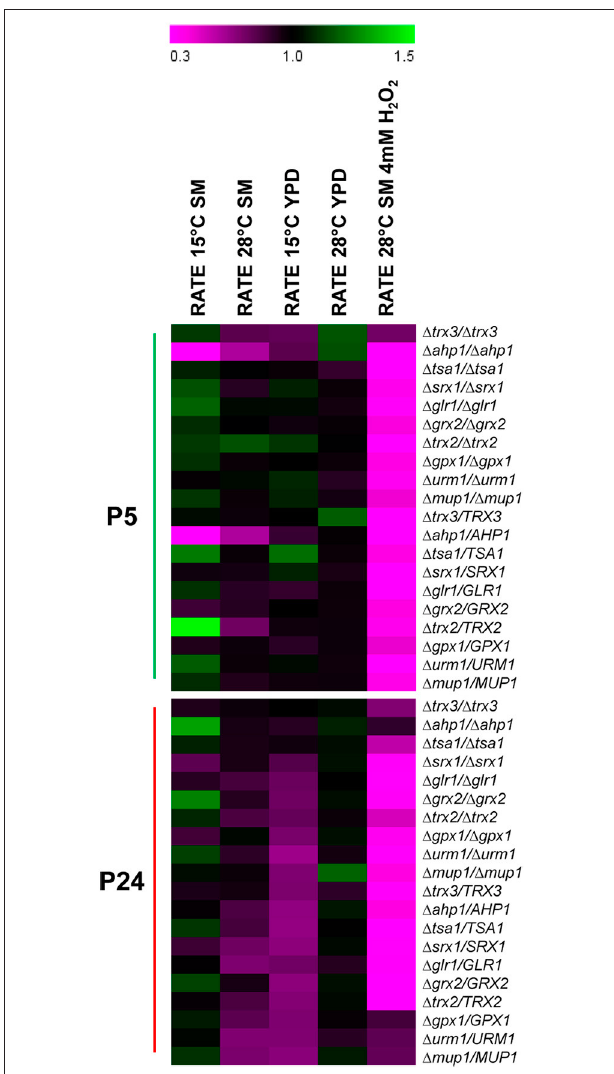
FIGURE 4 | Relative growth rate of the mutants constructed in the background of a wine strain. The selected genes of the BY4743 collection were deleted in strains P5 and P24 and their fitness was tested under different conditions. Values below 1 meant that the parameter was affected compared with the control strain. Sensitivity is indicated in purple, and resistance in